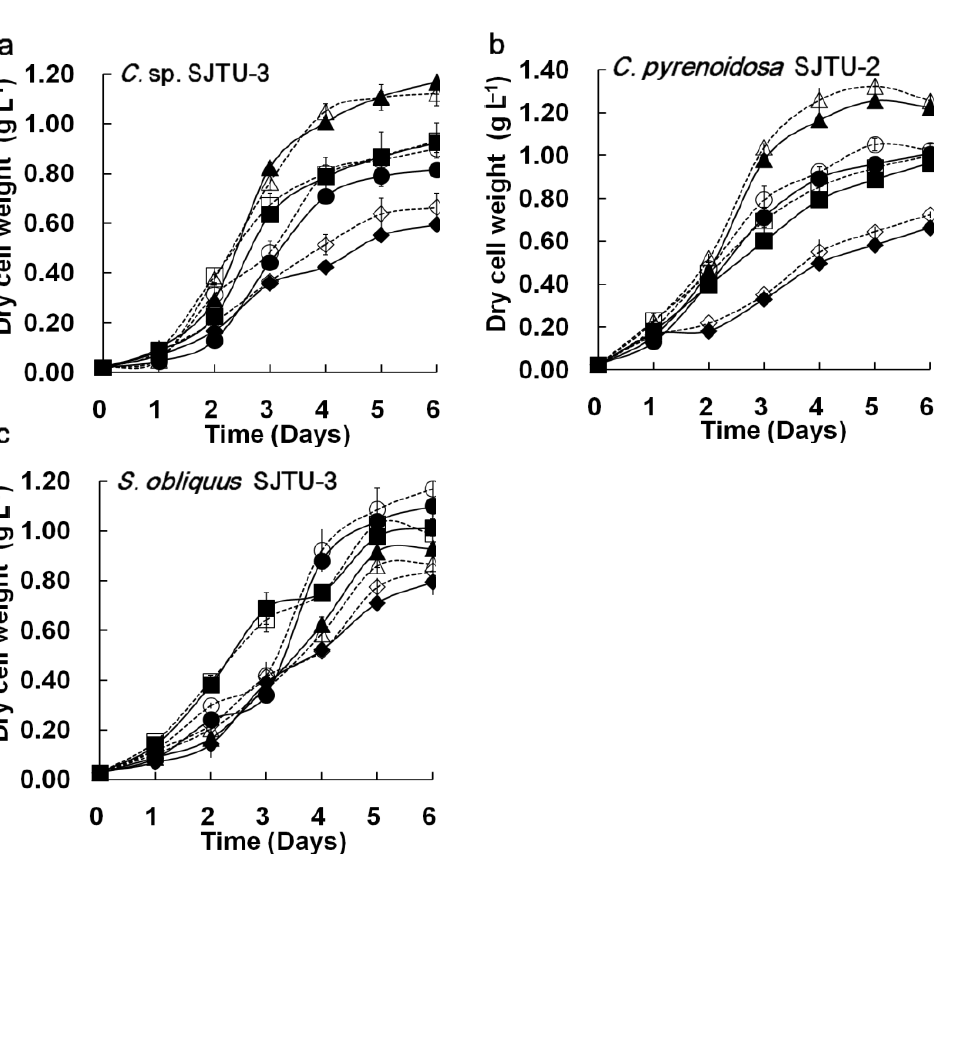
Figure 3. Comparison of microalgal dynamic growth characteristics in M96SS versus flask culture. The dotted line with hollow symbols represents cultivation in the M96SS. The Solid line with solid symbols represents cultivation in flasks. ( a – c ) Cell growth of 3 microalgae under different CO supply conditions. For symbols in (a–c), diamond: 2 0.2 g L −1 d −1 CO ; square: 0.4 g L −1 d −1 CO ; triangle: 0.8 g L −1 d −1 CO , cycle: 1.2 g L −1 d −1 2 2 2 CO . The hollow symbols represent the data in M96SS. Solid symbols represent the data in 2 flasks; ( d , e ) Residual nitrate and pH value of the culture media of 3 microalgae under their optimal CO supply conditions. For symbols in (d,e), diamond: C. sp. SJTU-3 in 2 0.8 g L −1 d −1 CO ; triangle: C. pyrenoidosa SJTU-2 in 0.8 g L −1 d −1 CO ; cycle: S. obliquus 2 2 SJTU-3 in 0.4 g L −1 d −1 CO . The hollow symbols represent the data in M96SS. Solid 2 symbols represent the data in flasks. The culture was illuminated at 180 μM m −2 s −1 and incubated at 25 ± 1 °C. Each cultivation was performed in